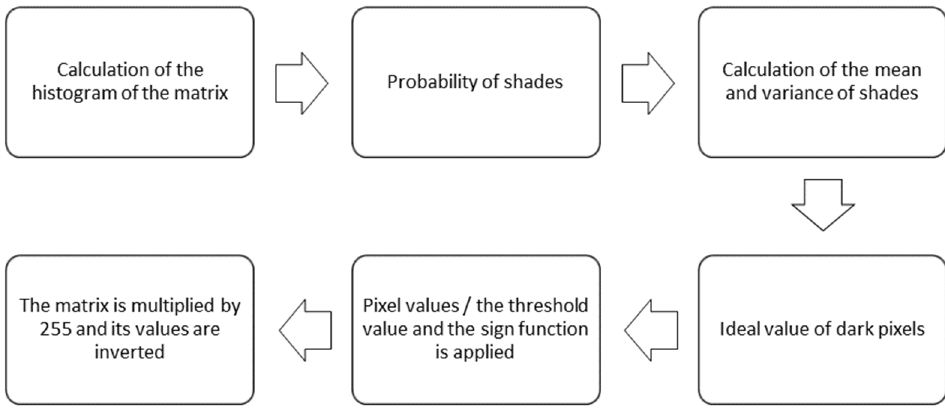
Figure A1. Phases for the binarization of the training images of the system.